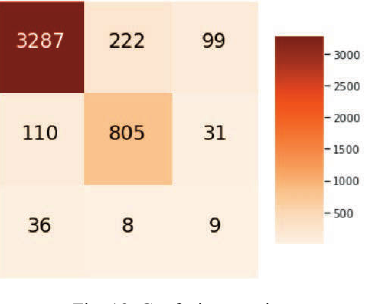
Fig. 19. Confusion